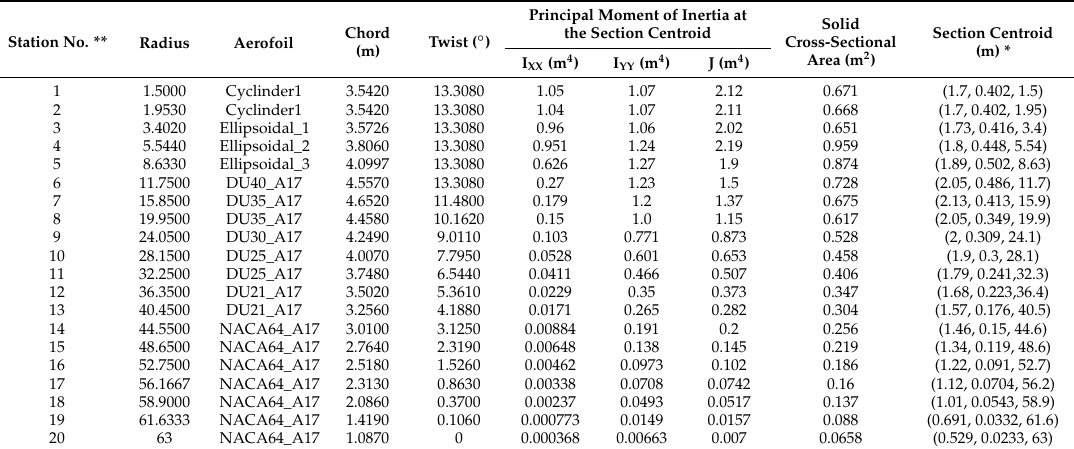
Table 1. Sectional properties of the blade.